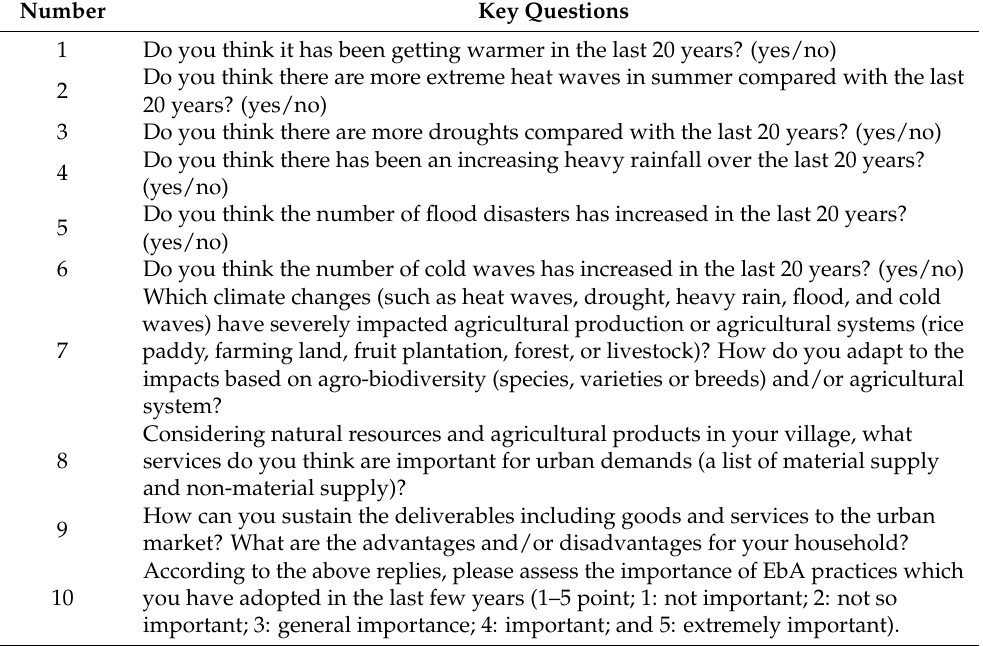
Table 1. Categories of semi-structured questionnaire around key topics.